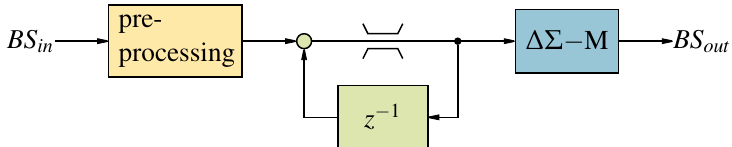
Figure 19. Generalized linear operation integration in ∆Σ